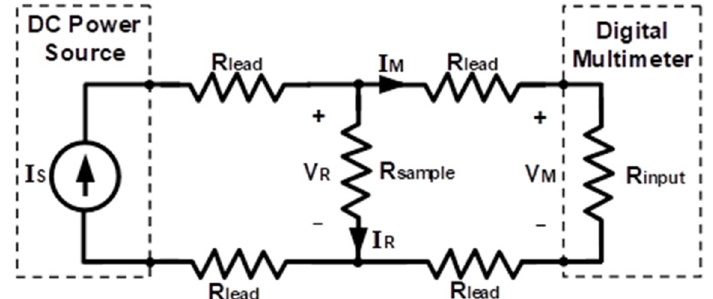
Figure 2. Experimental scheme used for four-wire resistivity measurements. V R is the voltage that the sample supports; I R is the current flowing through of the sample; R sample is the resistance sample. R lead is the resistance of the connecting cables; I S is the value of the current that the circuit supplies; V M is the voltage measured by this multimeter; R INPUT is the resistance of the multimeter and I M is the value of the current of the part of the multimeter circuit.